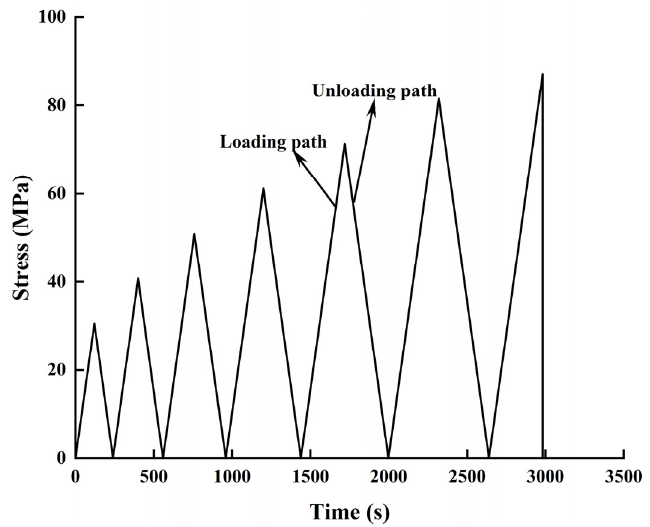
Figure 3. Circulation method.